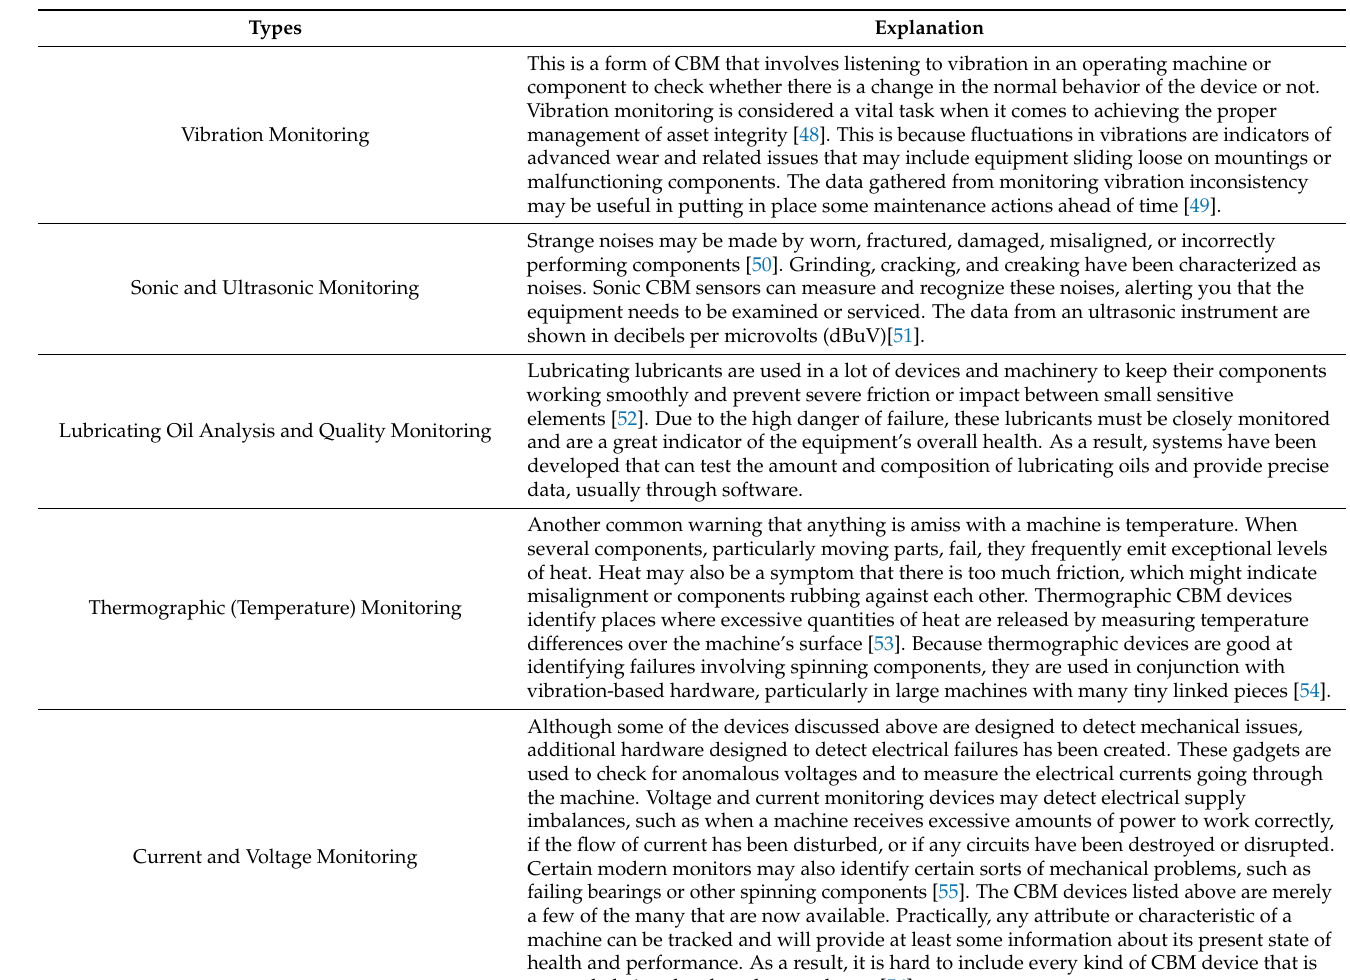
Table 4. Summary of the Types of Condition-Based